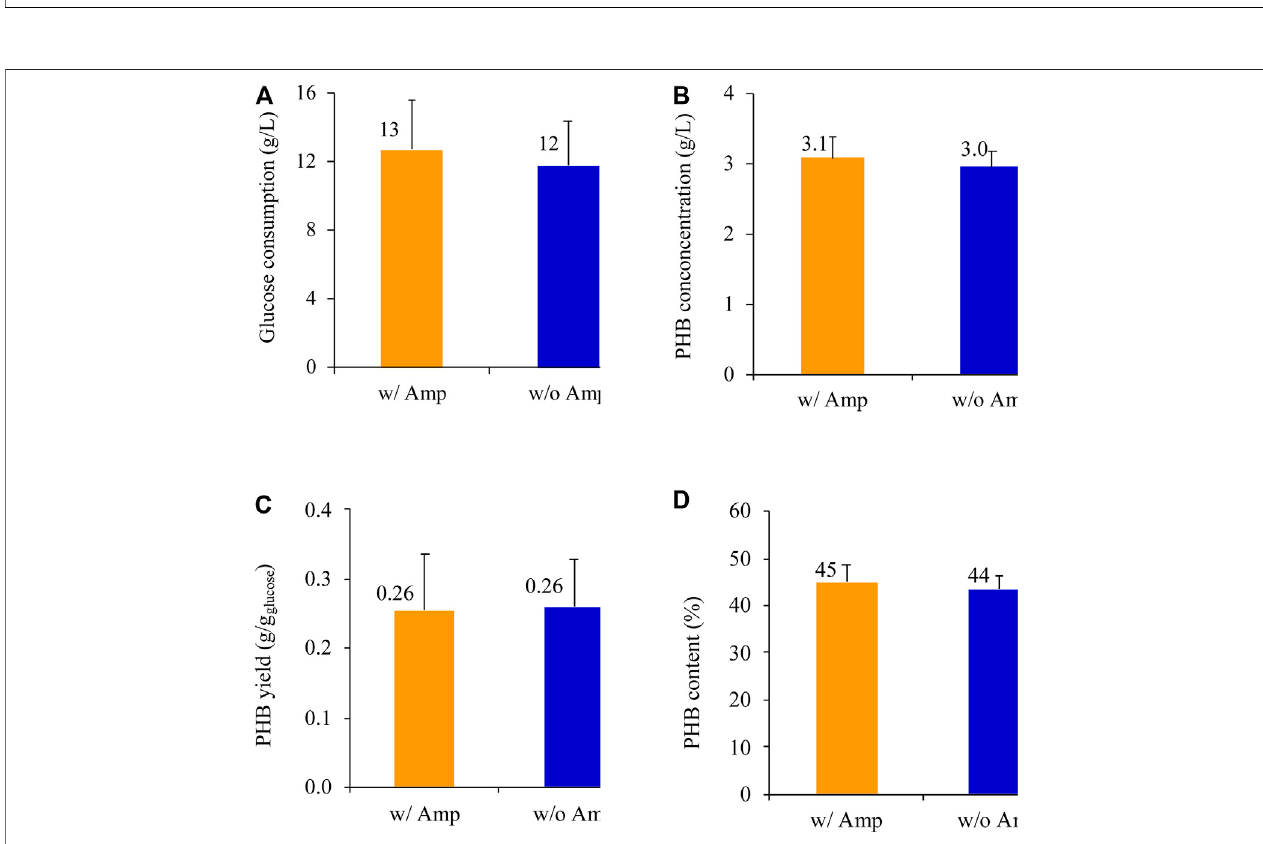
FIGURE 7 | (A) Glucose consumption, (B) PHB conconcentration, (C) PHB yield, and (D) PHB content of E. coli BL21 (DE3)/pPHB01-1 with out and with 100 μ g/ml ampicillin. The initial glucose concentration for conditions of with and without amp were 13 am3 and 12 a3 g/L, respectively. Errors represent standard deviation with n = 3.